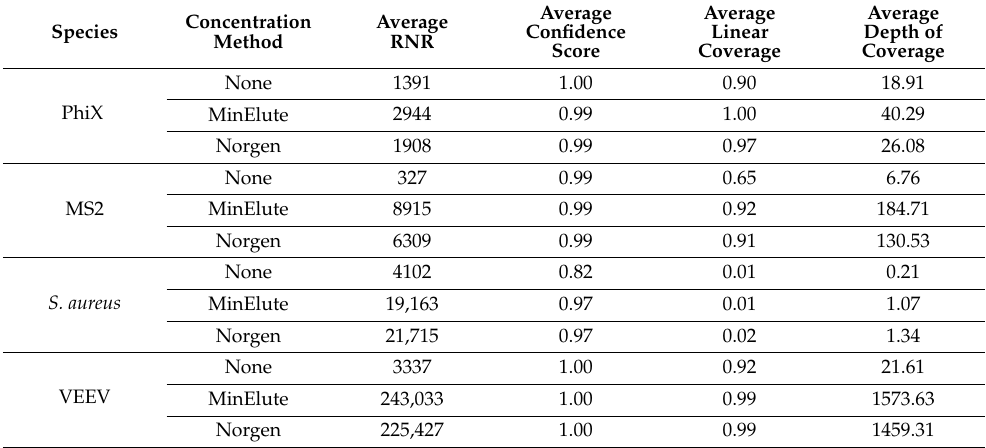
Table 3. Comparison of Concentration Kits (Norgen versus Qiagen). This table represents average results from replicates (n = 4) of each nucleic acid concentration method. We assessed the detection of target organisms by comparing performance metrics; RNR, Confidence Score, Linear Coverage and Depth of